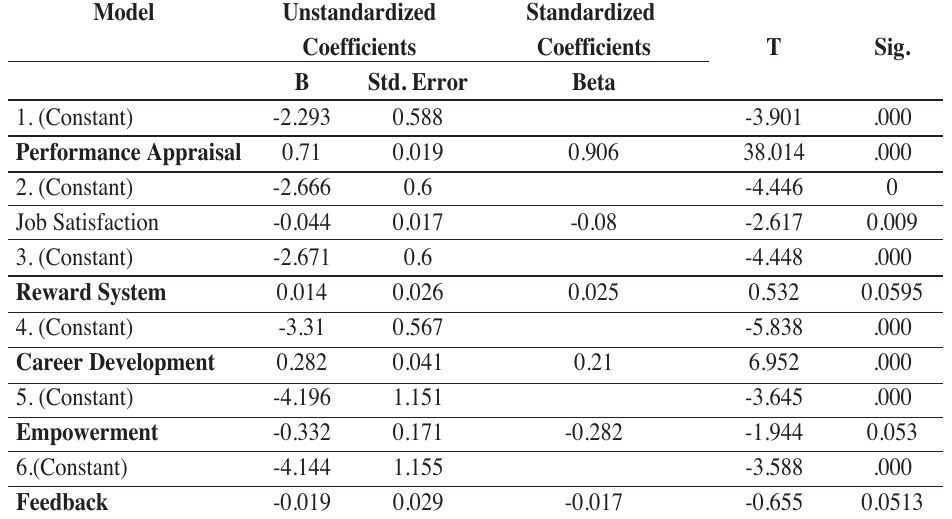
Table 6: Regression